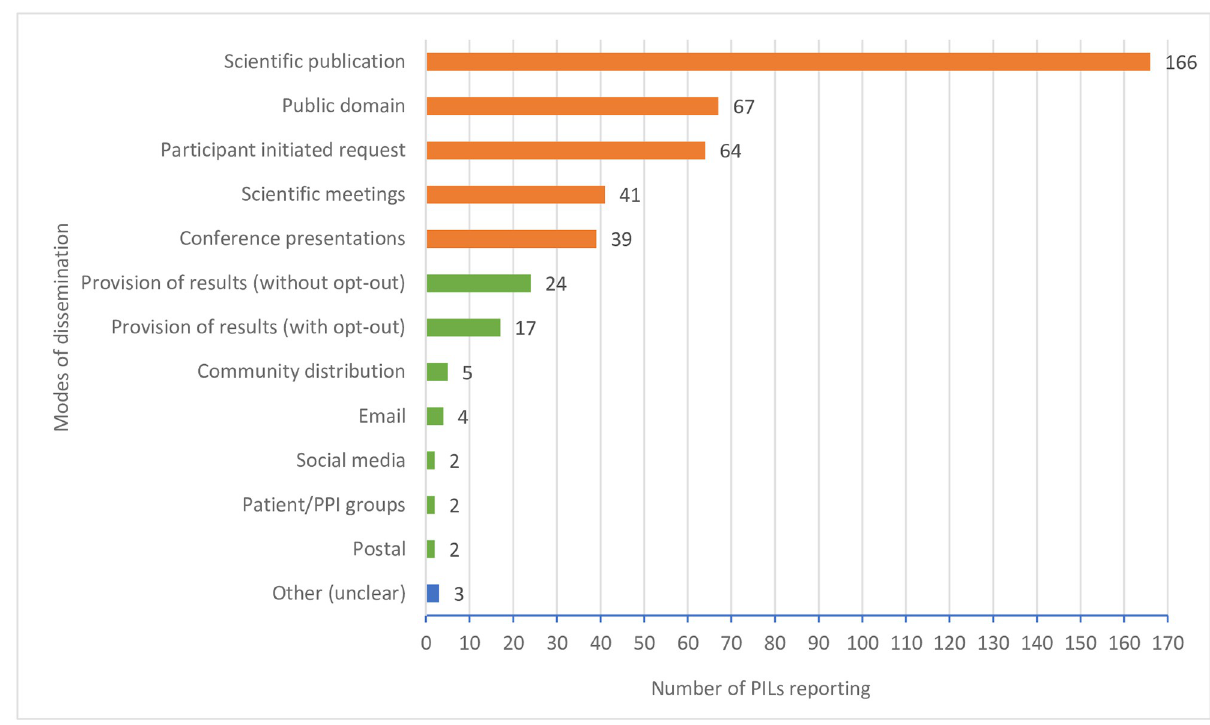
Fig 1. Graph of active and passive modes of dissemination of trial results summaries. (orange = active dissemination, green = passive dissemination, blue = unclear).